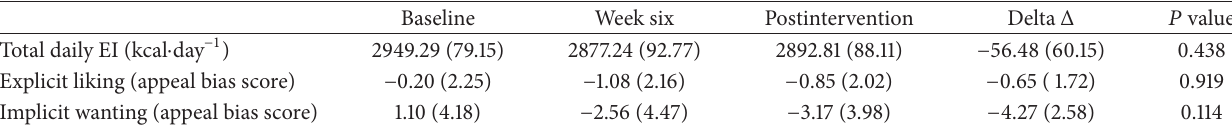
Table 2: Changes in food intake, explicit liking, and implicit wanting for high fat versus low fat foods during the 12-week exercise intervention ( 𝑛 = 46 ).